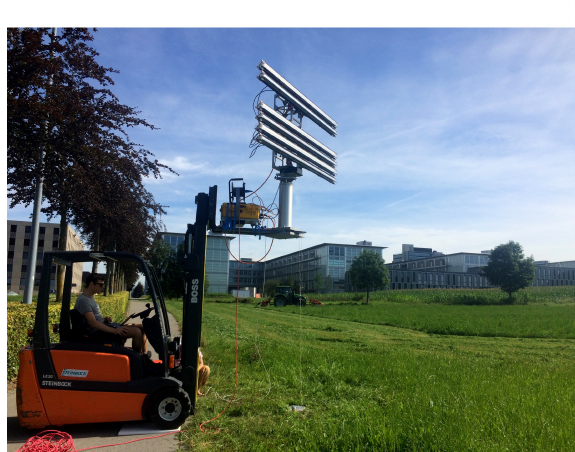
Figure 3. Hönggerberg experiment. The radar is mounted on a forklift to perform measurements at different elevations. In the near range, the lines of short cut grass separated by lines of piled grass and not yet mowed grass is visible. The observation area with a steeper slope is located at the far range and is not visible in the photograph.